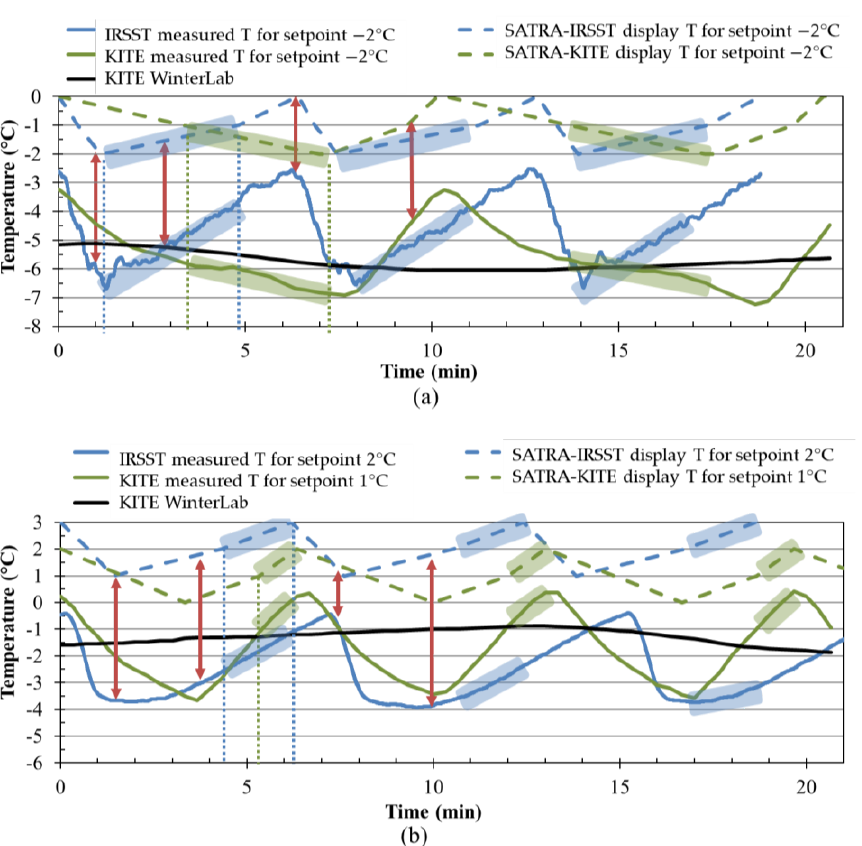
Figure 7. The temperature data recorded from WinterLab and SATRA machines in ( a ) dry ice and ( b ) wet ice conditions for both KITE and Institut de recherche Robert-Sauvé en santé et en sécurité du travail (IRSST) laboratories.